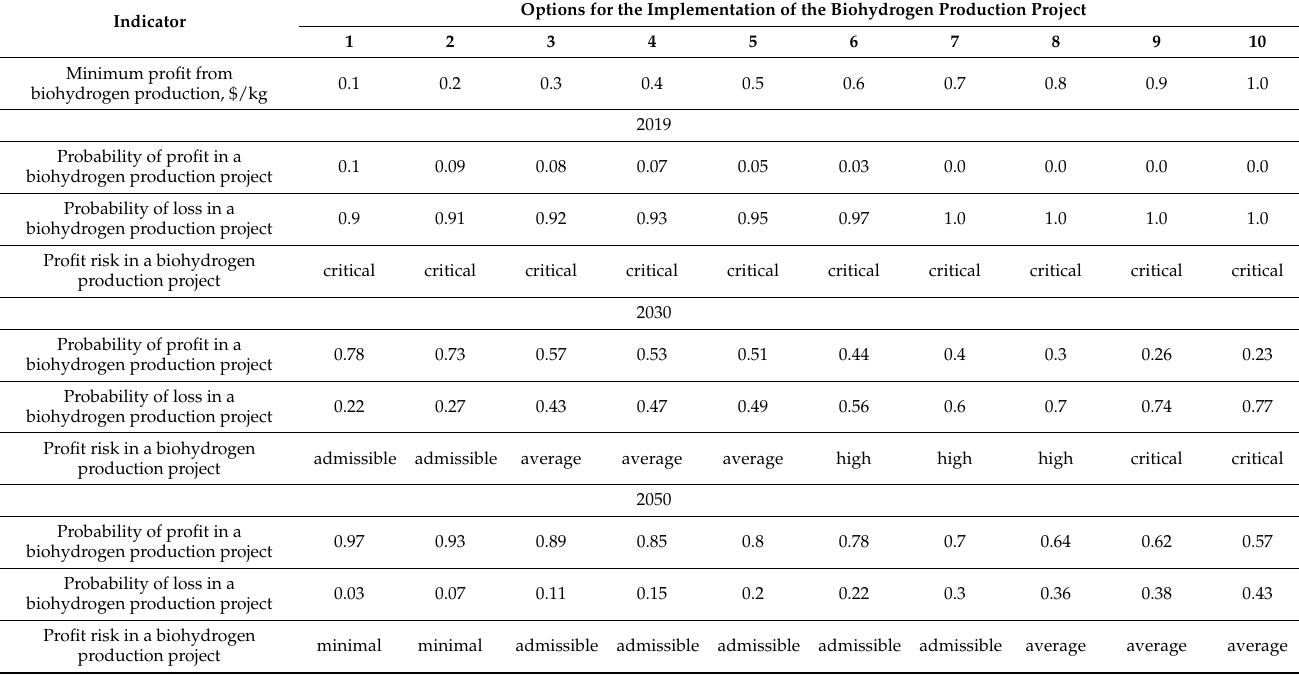
Table 2. The results of forecasting the quantitative profit risk indicators R ( P s ) in projects dedicated to the production of biohydrogen from agricultural raw materials 1 .